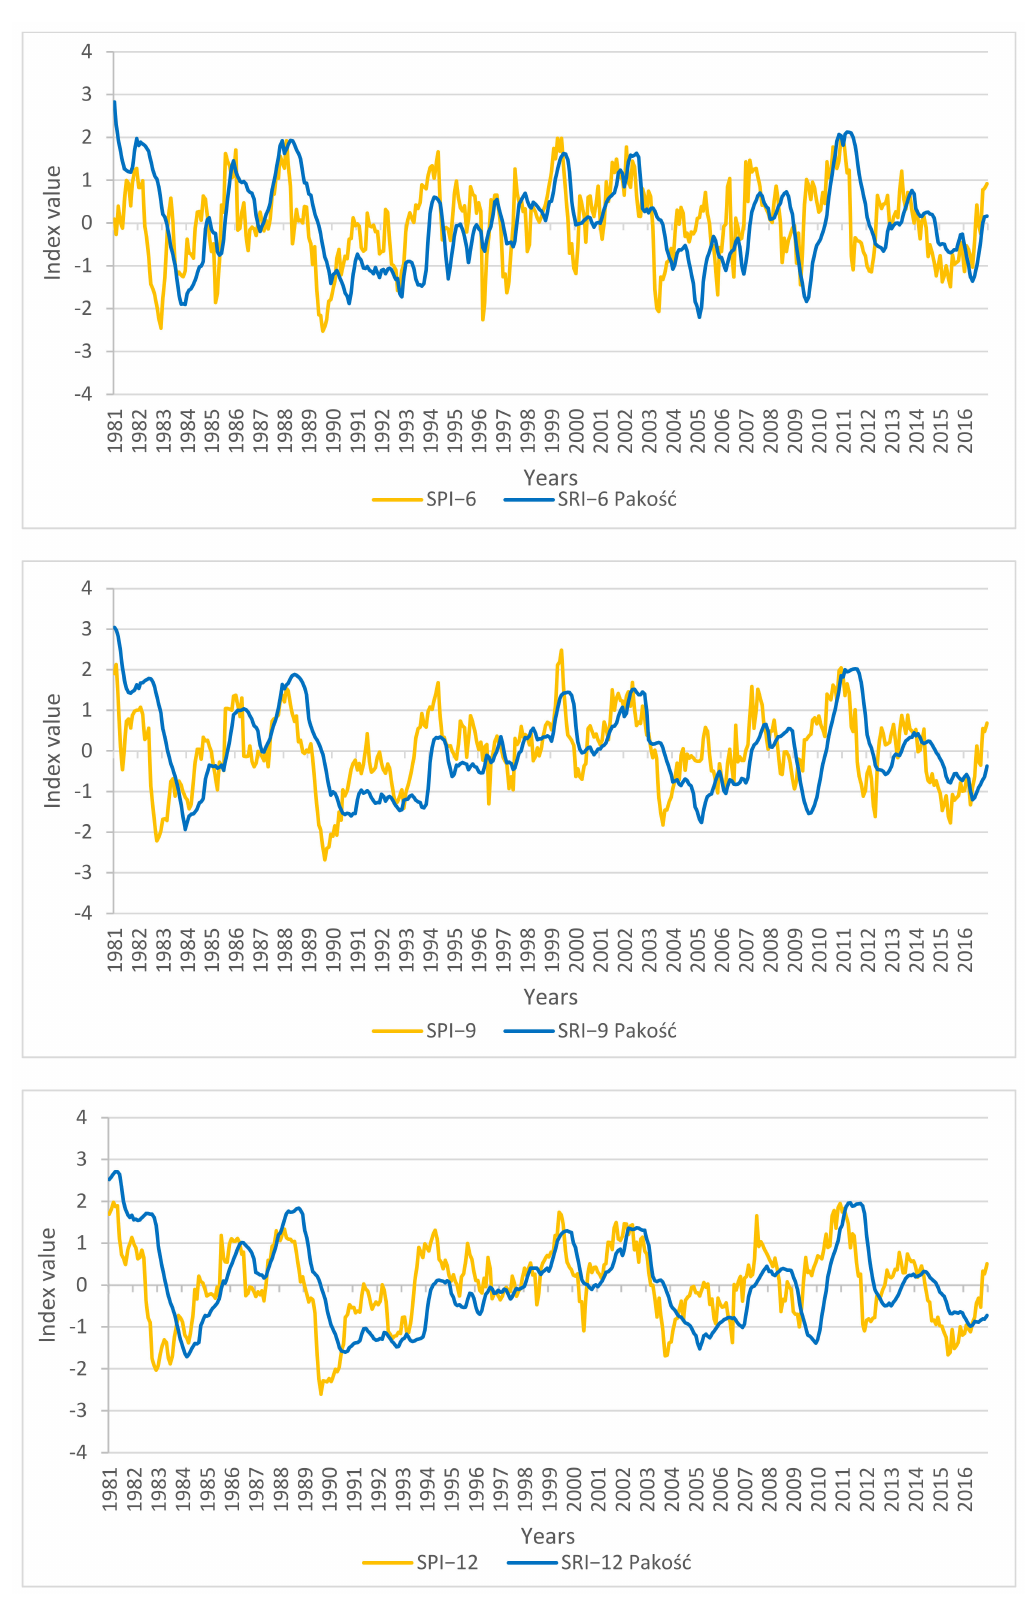
Figure 4. The development of meteorological and hydrological droughts in the period of 1981–2016 for different accumula- tion periods ( n = 1, 3, 6, 9 and 12), SPI—average values from 8 stations, SRI for